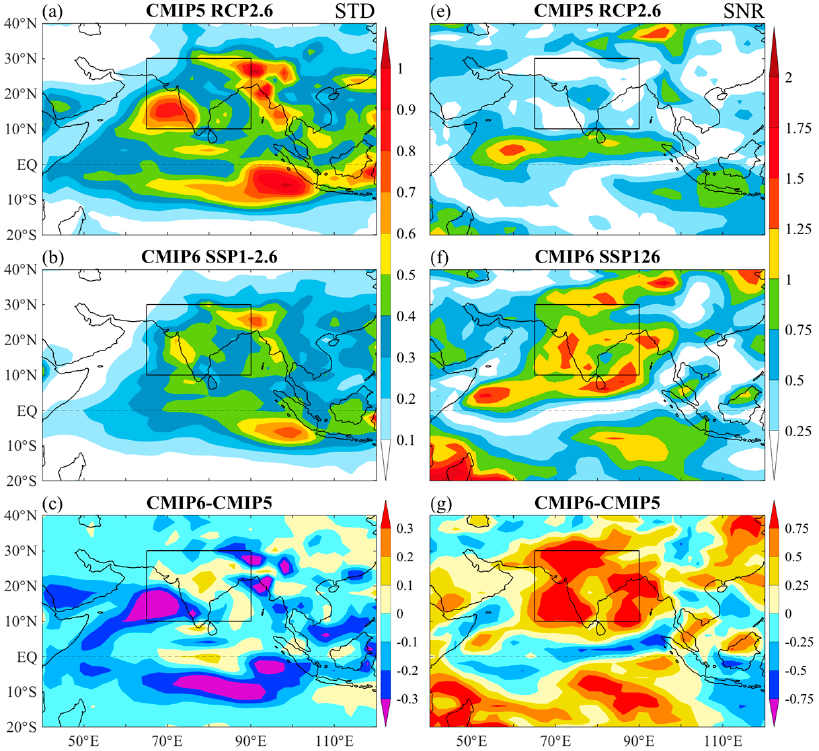
Figure 6. Intermodel standard deviation (STD, mm day − 1 ) of precipitation change under ( a ) RCP2.6 and ( b ) SSP1-2.6 and ( c ) their differences. Signal-to-Noise ratio (SNR) of the MME precipitation change under ( e ) RCP2.6 and ( f ) SSP1-2.6 and ( g ) their differences.